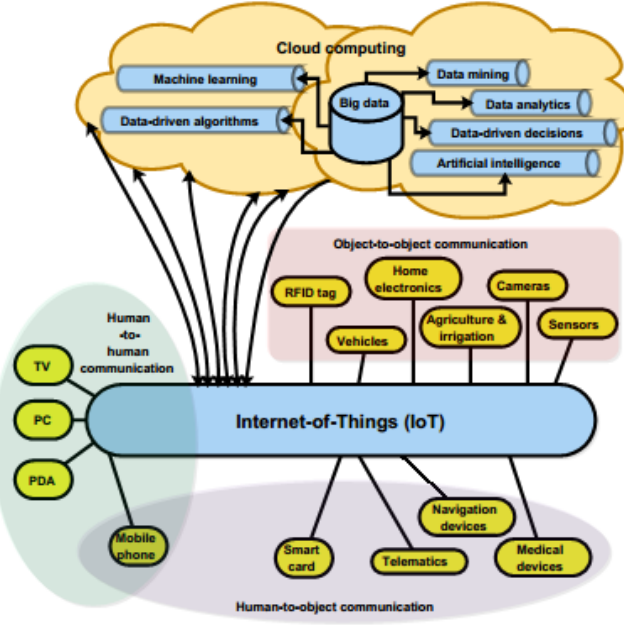
Figure 5. IoT interconnectivity and cloud